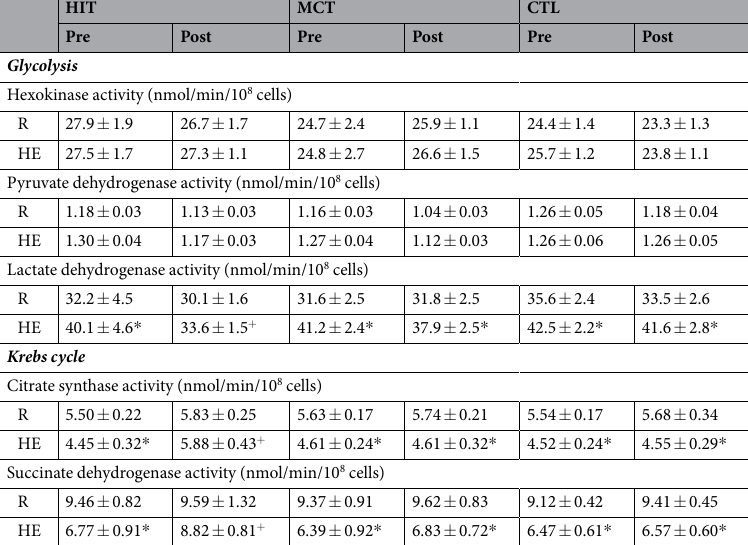
Table 3. The effects of interval and continuous exercise regimens on enzyme activities of glycolysis and Krebs cycle in platelets. Values were mean ± SEM. HIT, high-intensity interval training group; MCT, moderate- intensity continuous training group; CTL, control group; Pre, pre-intervention; Post, post-intervention; R, resting; HE, hypoxic exercise test. * P < 0.05, R vs. HE; + P < 0.05, P re vs.